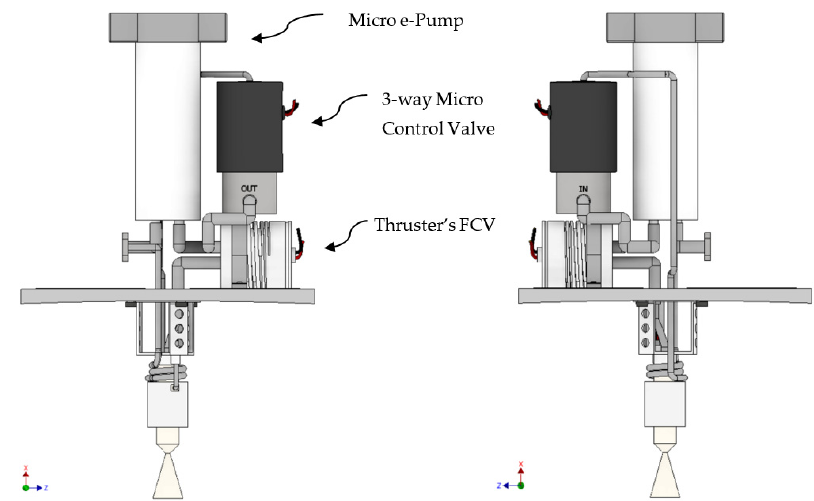
Figure A3. Feed and pressurization system side view and components.